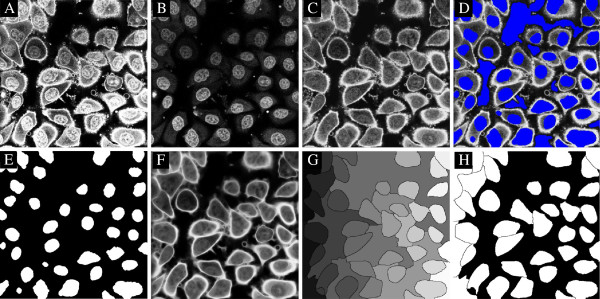
Segmentation of cells using nucleus markers in 2D from Example 7, executed for plane five in the image stack. A) Raw surface stain, B) raw nucleus stain, C) surface stain minus nucleus stain, D) markers (blue) derived from the nucleus stain superimposed onto the surface stain, E) cell markers, F) smoothed segmentation image, from C, G) watershed image, H) detected cell areas.